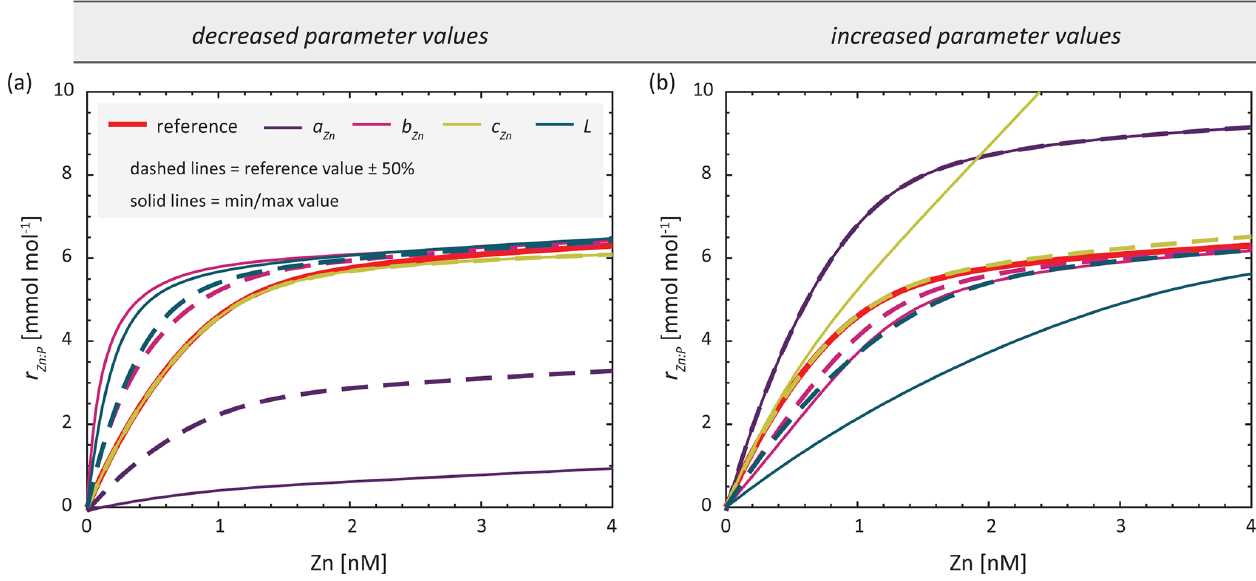
Figure 2. Zn:P stoichiometry of simulated uptake obtained with reference parameters (red) and by separately varying the parameters of Eq. (2). The stoichiometries are calculated with one parameter being (a) decreased or (b) increased by 50% (dashed lines) or set to the boundary value in Table 1 (solid line). Table 1. Reference parameter values and search